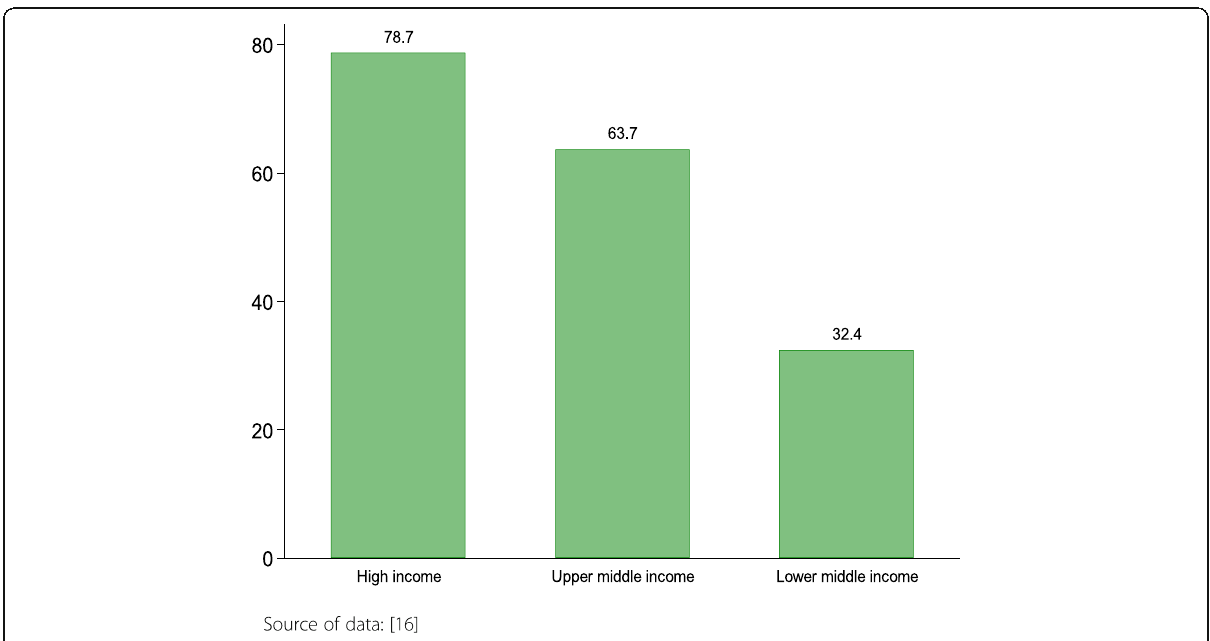
Fig. 5 General government expenditure on health as a percentage of total health expenditure, 2014, by income